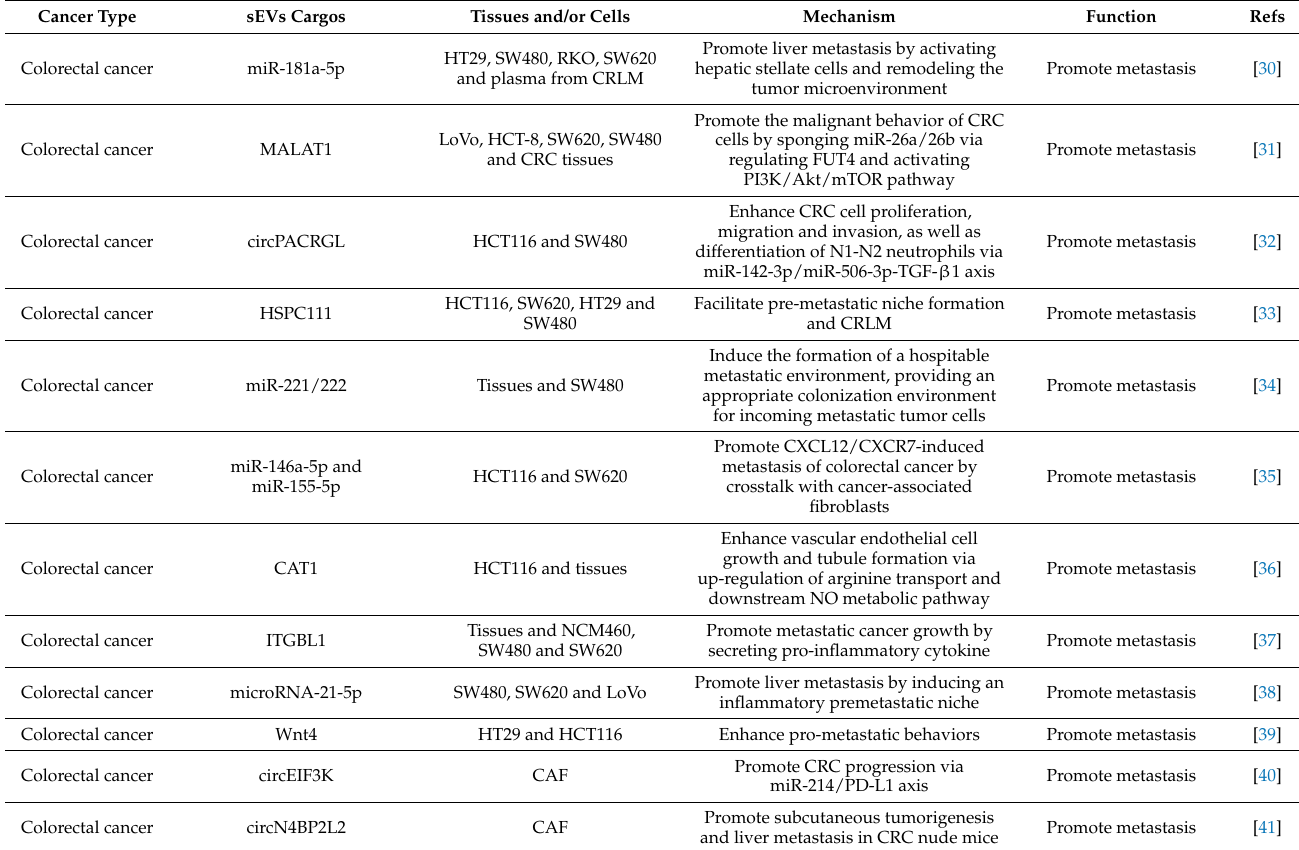
Table 1. sEVs affect CRC metastasis by remodeling the